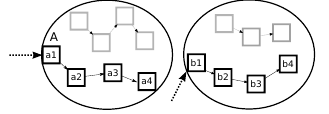
Figure 5: Models with processes started by the